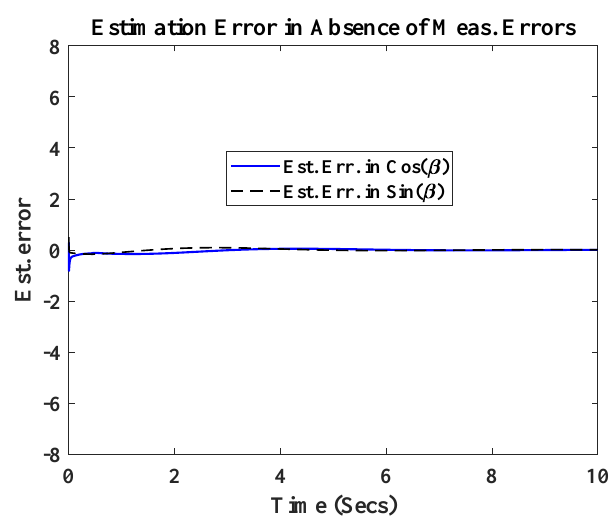
Figure 2. Circular path tracking without sensor errors.